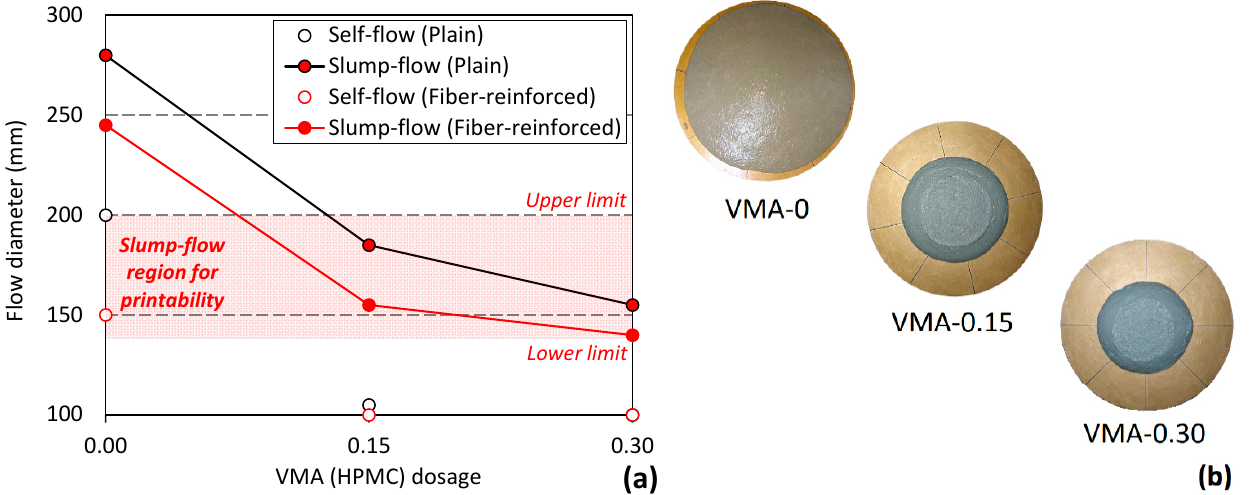
Figure 8. The flow diameters ( a ) and slump-flow spread views ( b ).